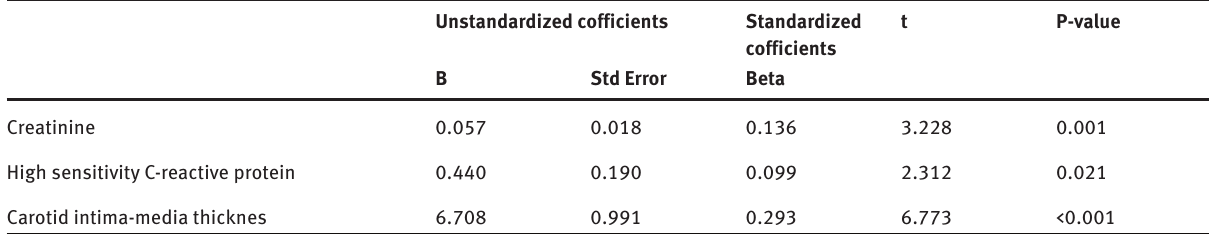
Table 3: Serum carbohydrate antigen 125 as dependent variable in multivariable linear regression analysis Unstandardized cofficients